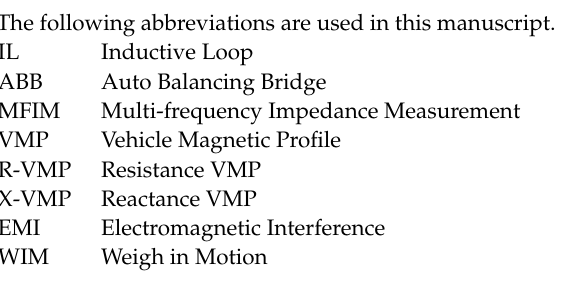
Figure A1. VMPs and EMIs of Hyundai i30 before denoising process. The rest of the description is the same as in Figure 2.